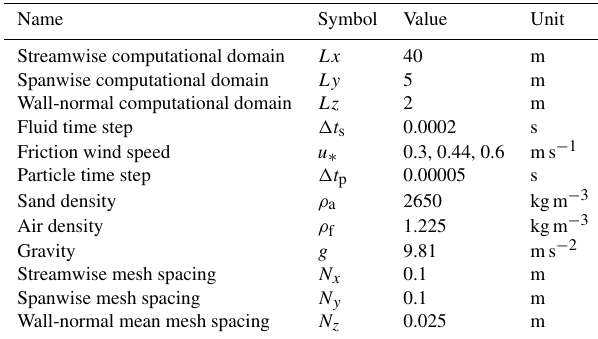
Table 2. Main simulation